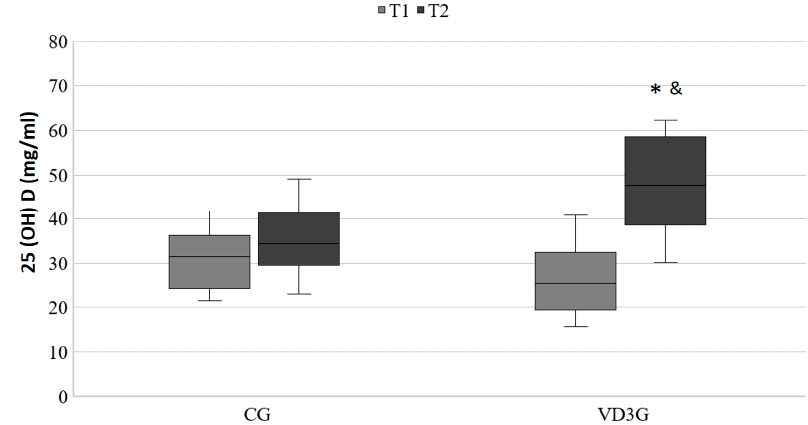
Figure 1. Serum 25(OH)D in the control group (CG) and vitamin D3 treatment group (VD3G) at baseline (T1) and after 8 weeks (T2). P: group-by-time interaction ( p < 0.05 all such occurrences). Two-factor repeated-measures ANOVA. * Significantly different between phases (T1 vs. T2). p < 0.05. & Significantly different between groups (CG vs. VD3G). p < 0.05.